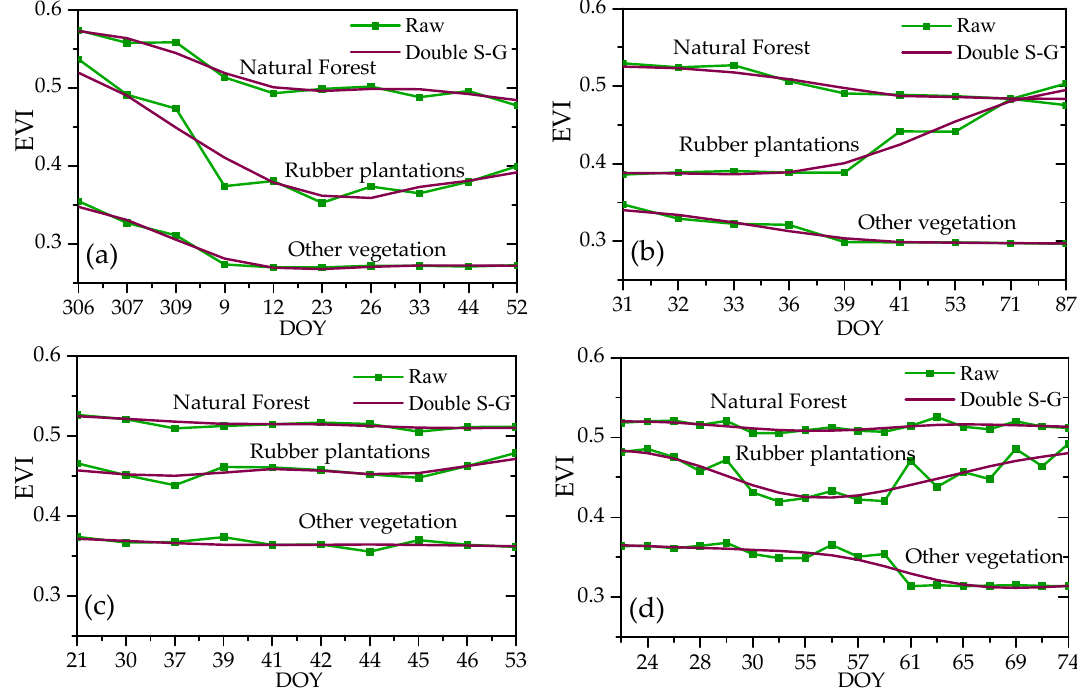
Figure 9. The time series of EVI data: ( a ) time series curves of the main vegetation coverage in 2000; ( b ) time series curves of the main vegetation coverage in 2005; ( c ) time series curves of the main vegetation coverage in 2010; ( d ) time series curves of the main vegetation coverage in